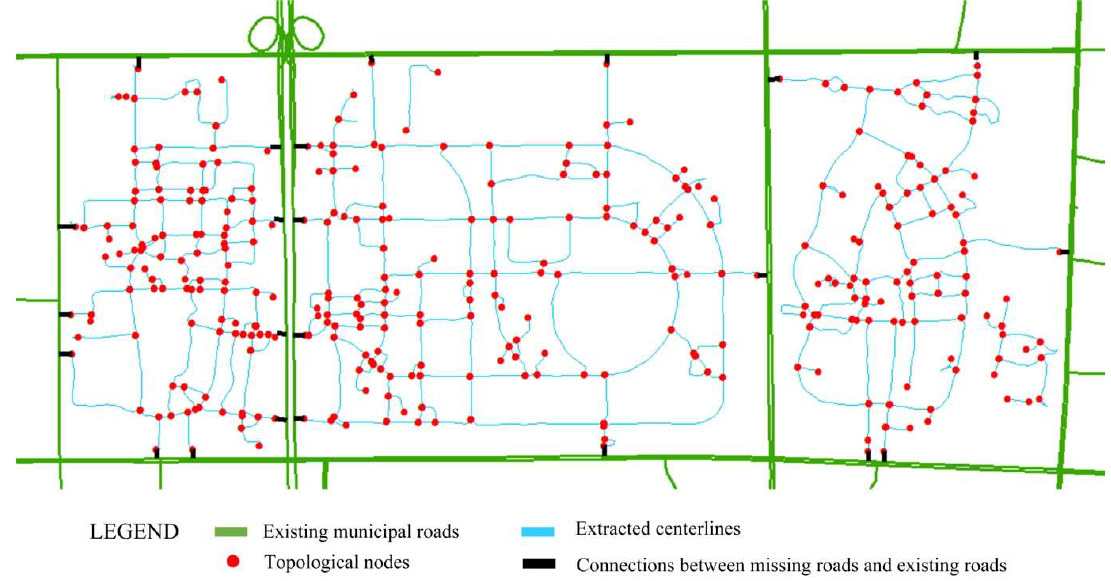
Figure 10. Results of the case study.